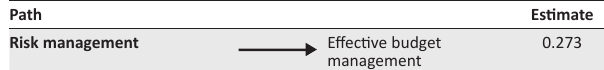
TABLE 15: Risk management (Hypothesis 4).